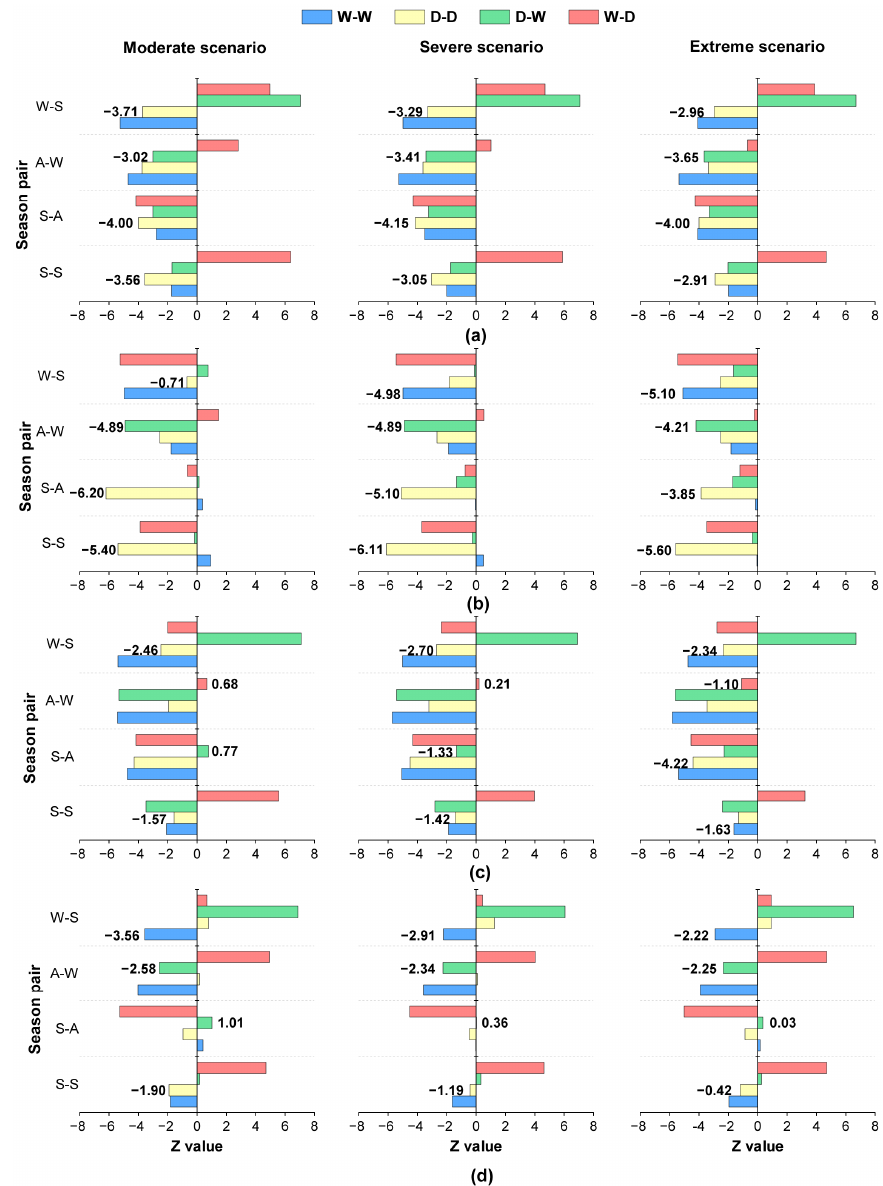
Figure 5. Trend detection of joint return periods of dryness–wetness combinations under three severity scenarios over the past half ‐ century at ( a ) the upper reach, ( b ) the Yishusi River basin, ( c ) the middle reach and ( d ) the lower reach of the HRB. Results are presented in the form of the MK test statistic Z . Z values in bold correspond to the most frequent combinations identified for each season